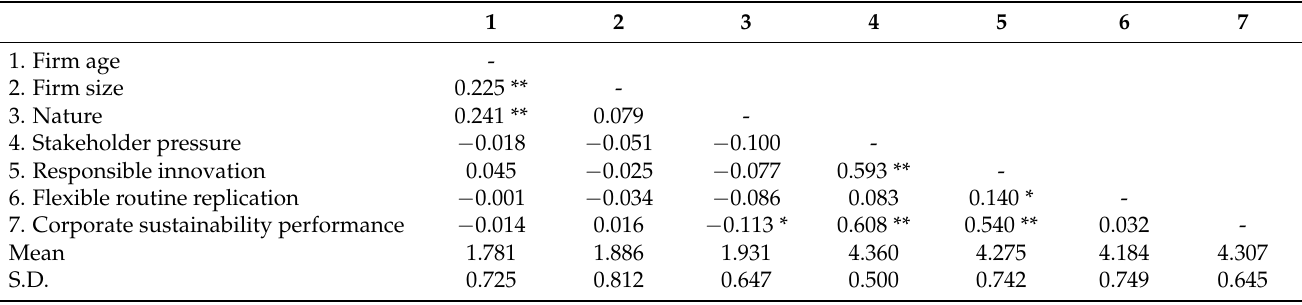
Table 2. Descriptive statistical analysis.